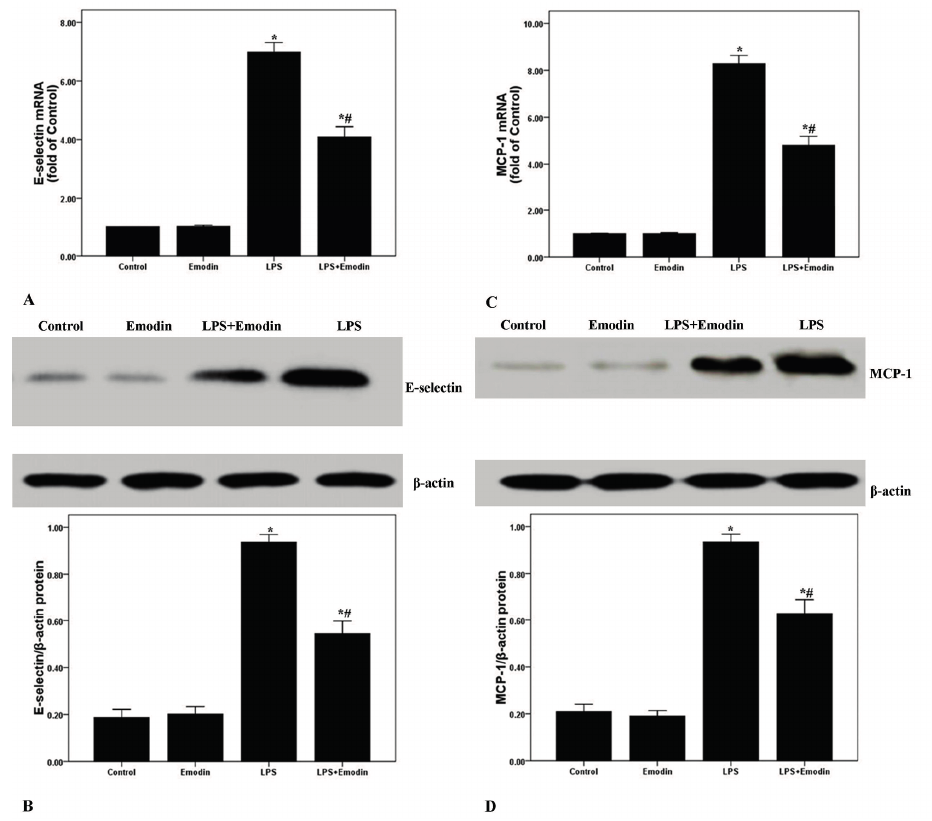
Figure 4. Emodin reduces E-selectin and MCP-1 expression in the lung tissues in LPS-induced ALI. After 72 h interventions, mice were exsanguinated and their lungs were removed. ( A , C ) qPCR was performed to analyze E-selectin and MCP-1 mRNA expression in the lung tissues; ( B , D ) Western blotting was performed to measure E-selectin and MCP-1 protein expression in the lung tissues. Each bar represents the mean ± SD of 10 mice. * p < 0.05 compared with Control. # p < 0.05 compared with